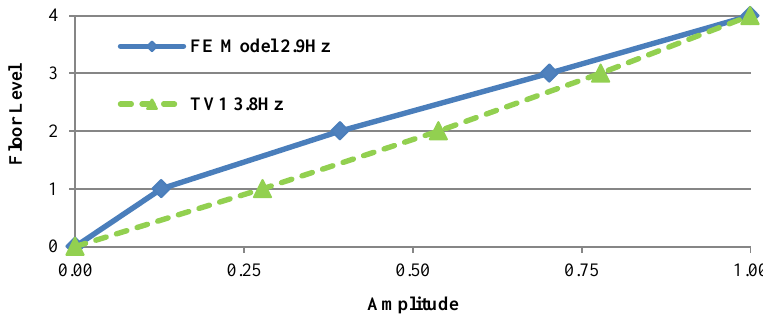
Fig. 9. Comparison of the first mode shapes from TV1 and the FE